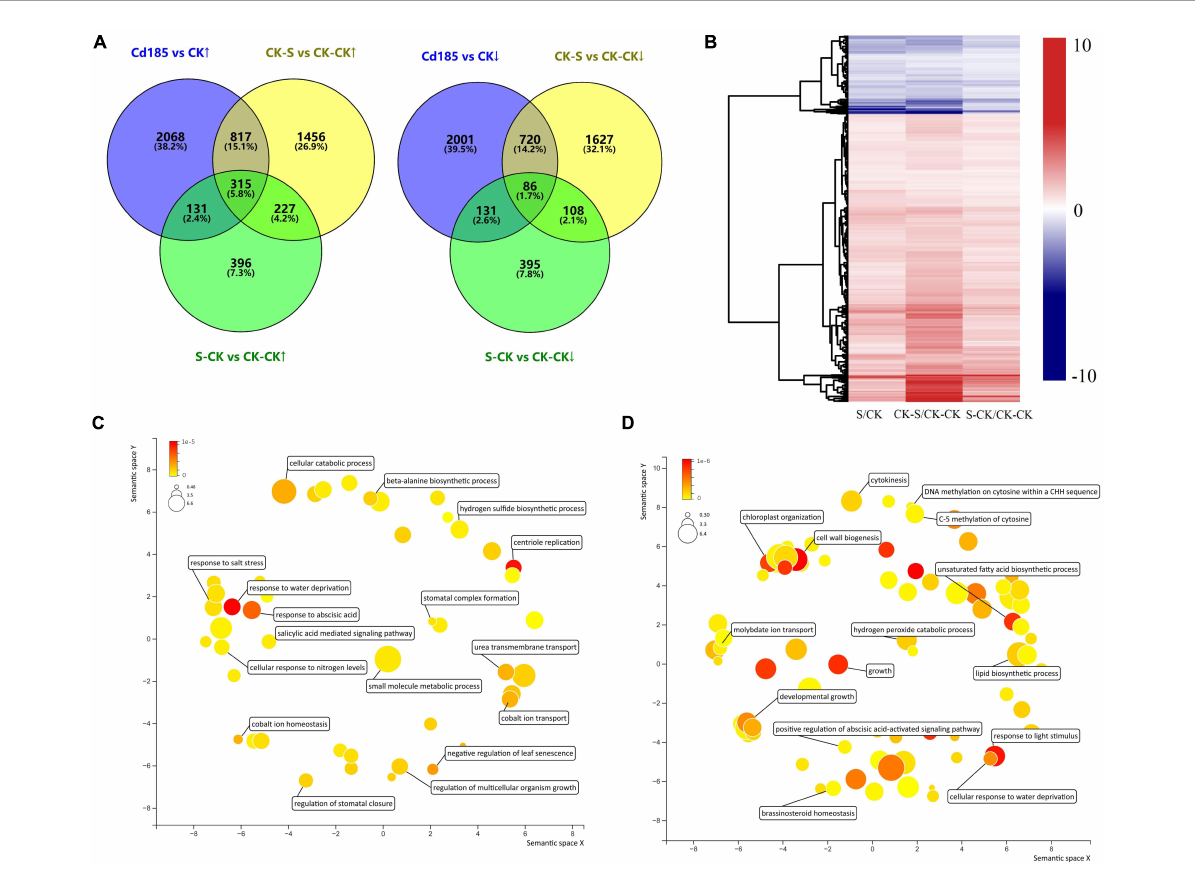
FIGURE5 Identification and characterization of Cd-responsive TMGs. (A) Comparison and distribution of upregulated and downregulated genes in Cd185 (G1), CK-S (G2), and S-CK (G2) using CK (G1) and CK-CK (G2) as controls. Genes with intersection were identified as TMGs. (B) Heatmap showing the expression profile of TMGs. The color scale represents log 2 fold change between different comparison pairs. (C,D) Biological processes of downregulated (C) and upregulated (D) TMGs. Representative biological processes are labeled; the color and size were adjusted to p -value and log 10 p -value,